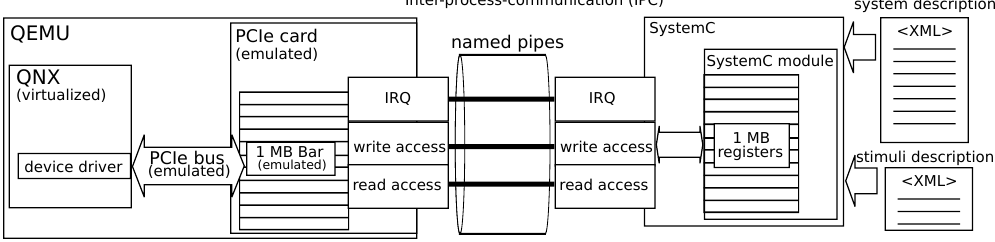
Figure 3: Overview of our hardware-software